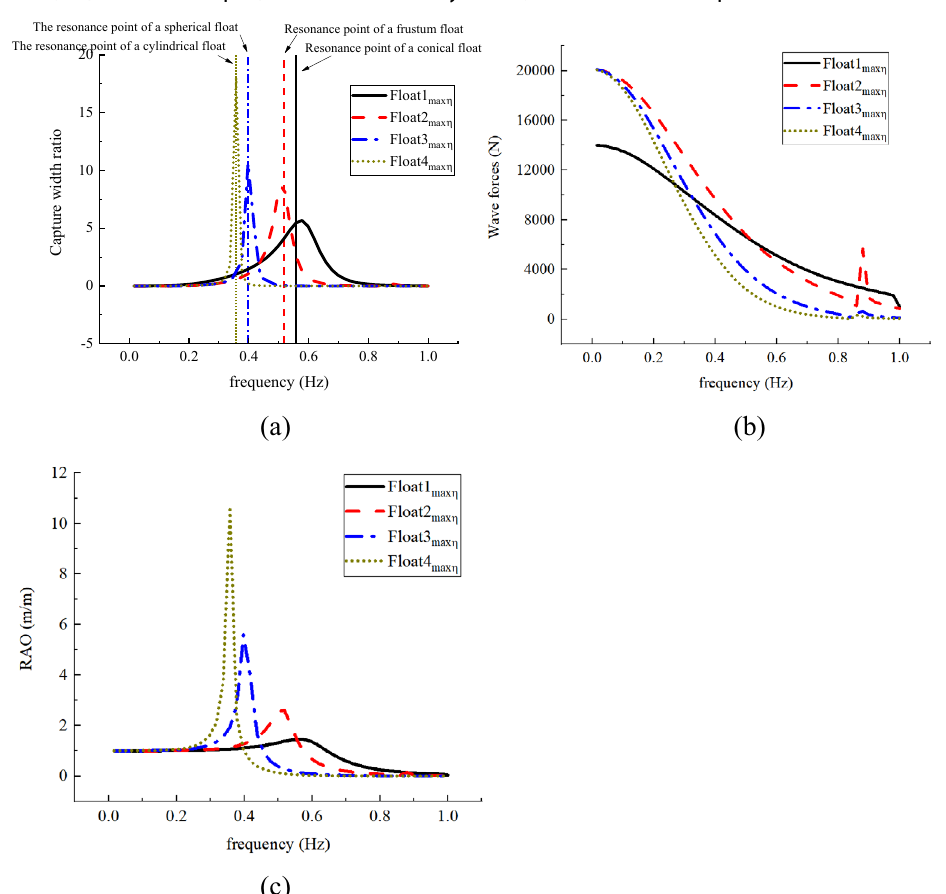
Fig. 3 Hydrodynamic characteristics of floats with different shapes at the maximum capture width ratio: a capture width ratio, b wave force, and c